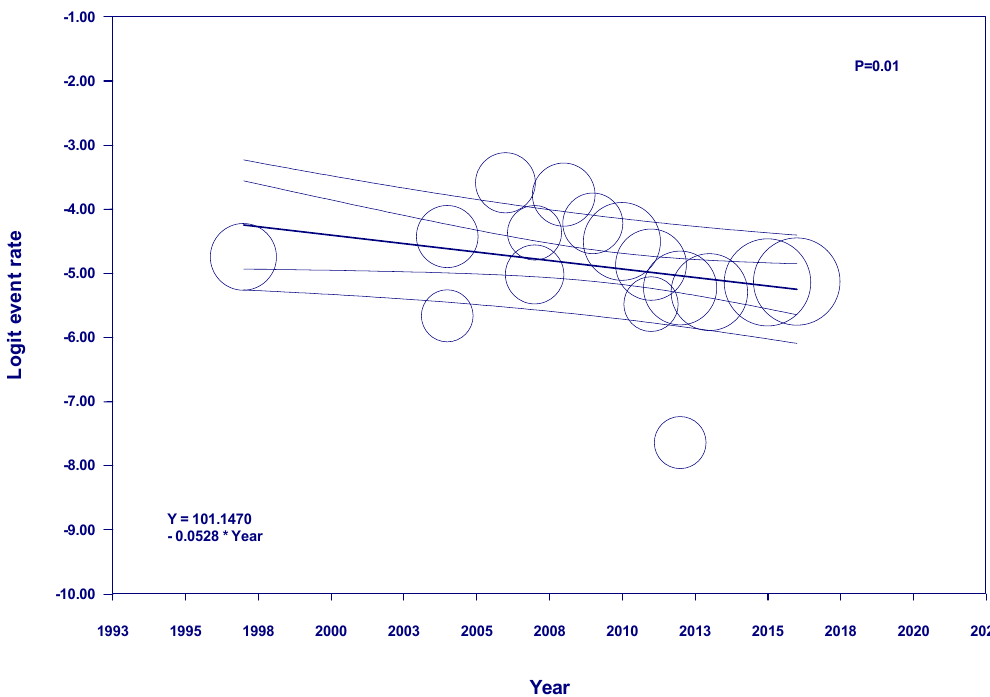
Figure 4. Meta-regression analyses showed a significant negative correlation between the year of study and incidence of de novo RCC post-KTx (slopes = − 0.05, p = 0.01). The solid line represents the weighted regression line based on variance-weighted least squares. The inner and outer lines show the 95% confidence interval and prediction interval around the regression line. The circles indicate the log event rates in each study.